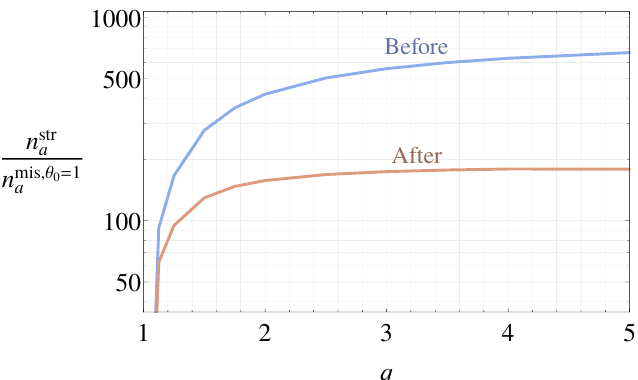
Figure 26: The axion number density from strings relative to that from misalignment, as a function of the power law q of the axion emission spectrum during scaling. We = 10 and α = 8. The results are shown before and after have fixed ξ (cid:63) log (cid:63) = 10 3 , x 0 the axion mass becomes cosmologically relevant.